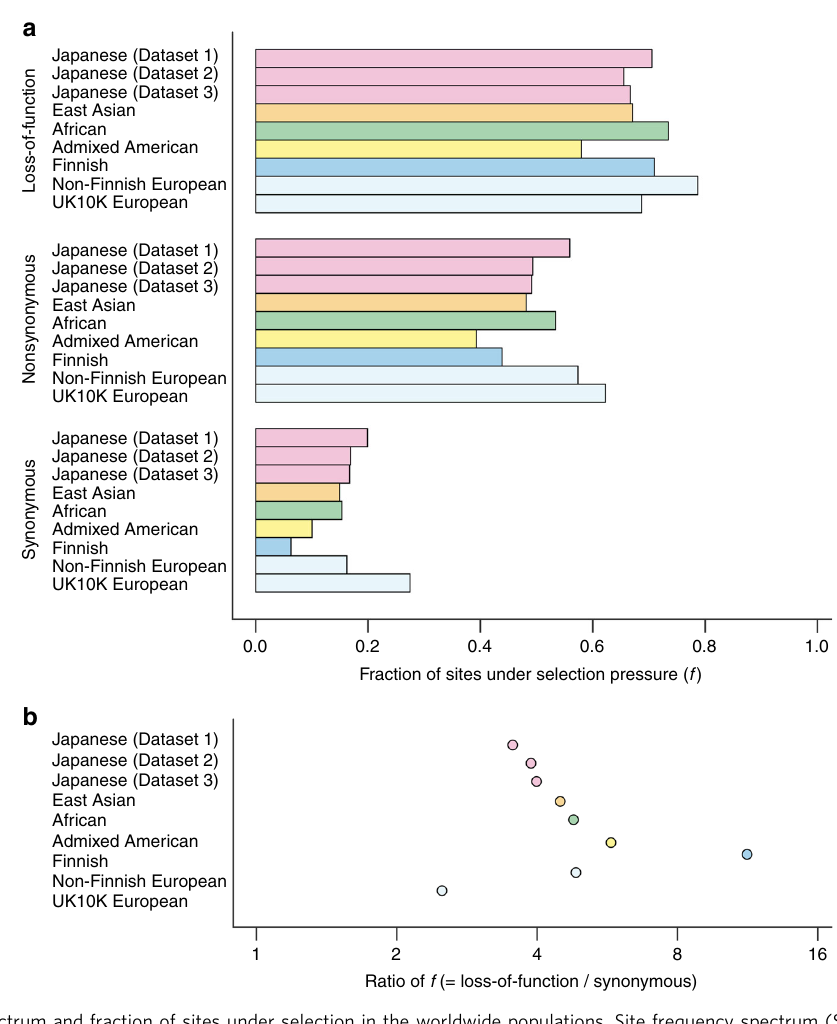
Fig. 1 Site frequency spectrum and fraction of sites under selection in the worldwide populations. Site frequency spectrum (SFS) estimated for the worldwide populations. In addition to the Japanese WGS datasets, data obtained from the Genome Aggregation Database (gnomAD; African, admixed American, east Asian, Finnish, and Non-Finnish European) and the UK10K project (European) are indicated 13,17 . a Fraction of sites under selection pressure ( = f ) calculated separately for loss-of-of-function variants, nonsynonymous SNV, or synonymous SNV. b Ratio of f between loss-of-of-function variants and synonymous